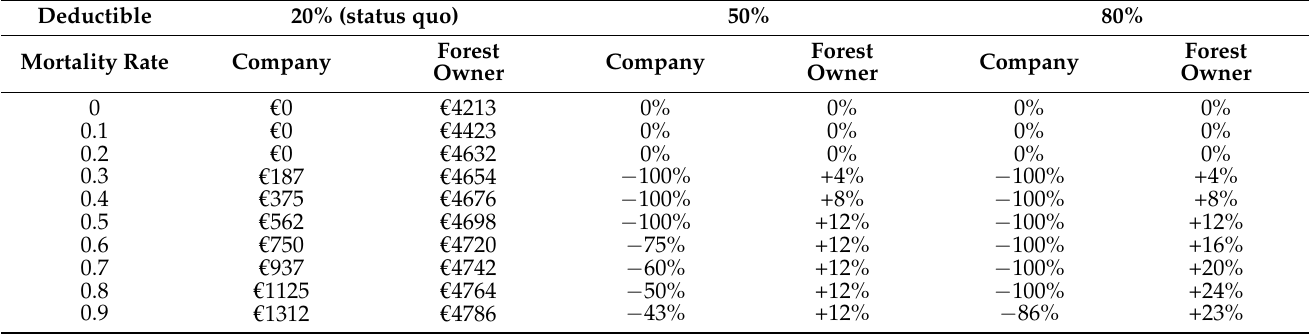
Table 7. Total discounted costs in EUR/ha for Douglas fir ( Pseudotsuga menziessi Mirb.) (itinerary “DF_CS-IP+R”) for the forestry company and the forest owner for a deductible of 20% (current practice), 50%, and 80%. The costs are expressed (for different mortality rates) as variations in percentage of the total discounted costs with respect to the current practice (i.e., status quo).